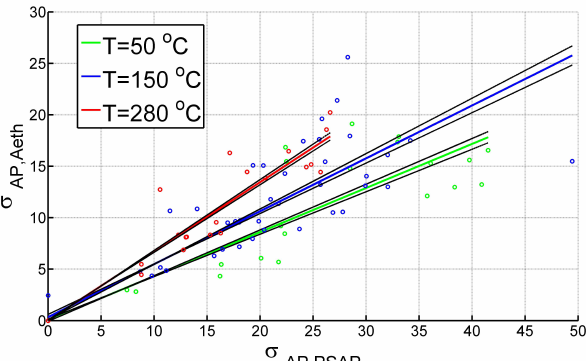
Fig. 7. The temperatures influence on the correlation between the absorption coefficients measurements on the heated aerosol ( σ AP , PSAP ) versus the cool aerosol ( σ AP , AETH